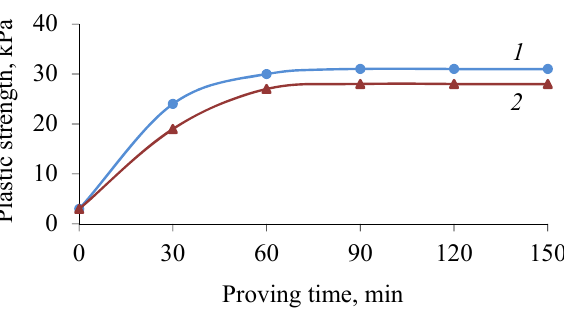
Fig. 1. Change in the proving of the plastic strength of jelly mass of the composition agar and: ( 1 ) sugar + molasses + apple puree; ( 2 ) stevioside + apple puree.